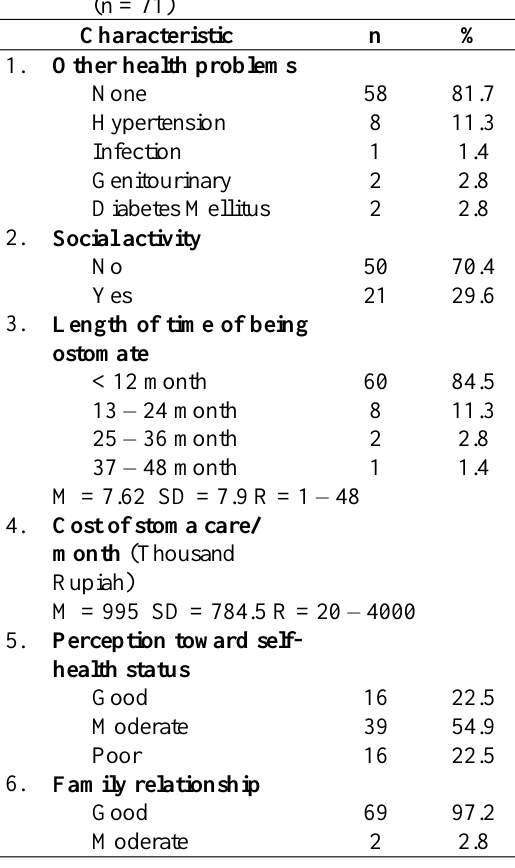
Table 3. Perceived quality of life and